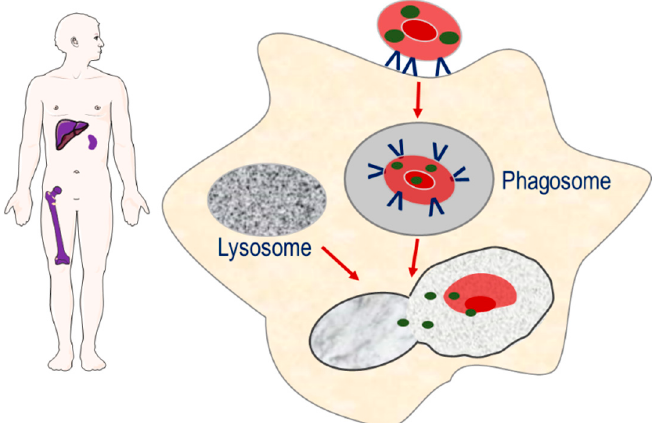
Figure 2. Strategy for targeting enzymes to the monocyte–macrophage system of the spleen, liver and bone marrow. Senescent erythrocyte carriers loaded with enzymes are removed from the circulation by macrophages. The resulting phagosome fuses with macromolecule-laden lysosomes, resulting in the release of enzyme and breakdown of macromolecules.